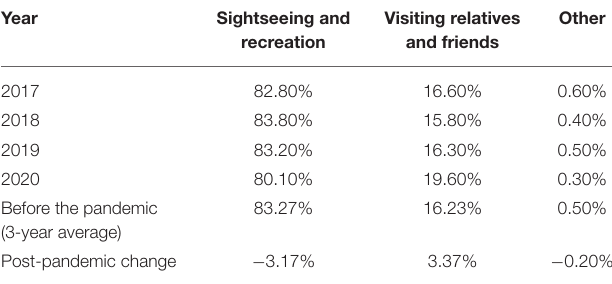
TABLE 4 | The purpose of